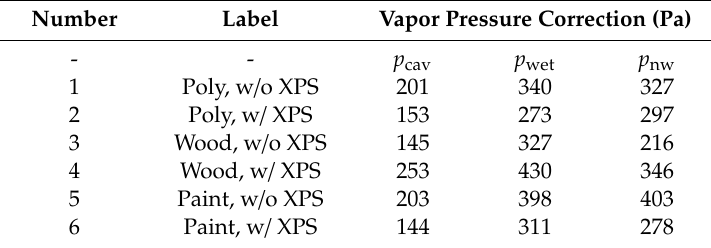
Table A1. Vapor pressure corrections to match laboratory.